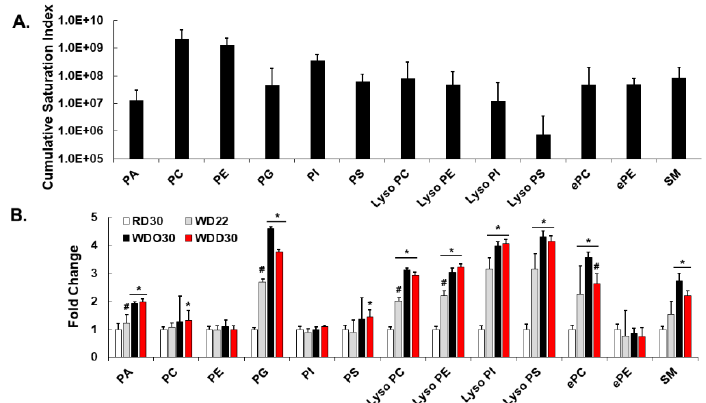
Figure 2. Diet e ff ects on membrane lipids. ( A ): Cumulative saturation index of lipids in each lipid class. The saturation index (SI) was calculated as follows: one minus (number of double bonds) divided by (number of fatty acyl carbons minus one). The cumulative saturation index was calculated by multiplying the SI by the peak intensity of each lipid species and summing all lipids within each lipid class. ( B) : E ff ect of diet on the cumulative saturation index for each lipid class. Results are presented as fold change, mean ± standard error of the mean (SEM); *, q < 0.05 vs. RD30; #, q < 0.05 vs. WDO30; [ q -value is the false discovery rate (FDR) adjusted p -value].